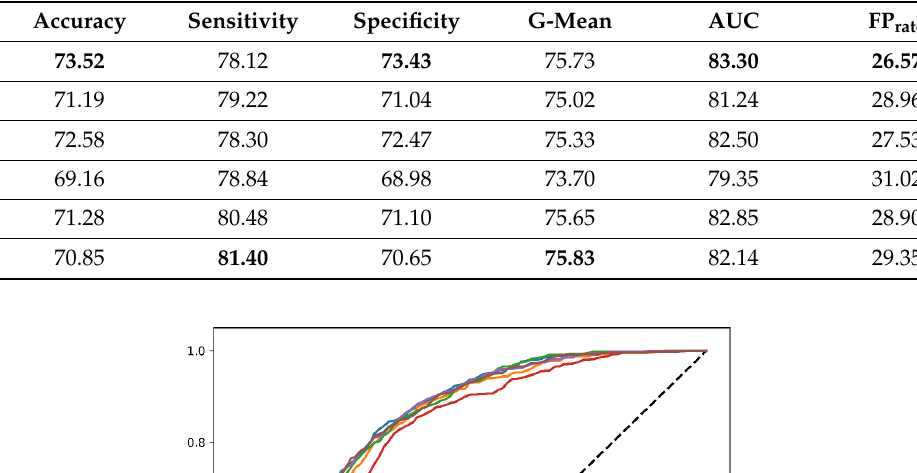
Table 3. Mean results of prediction models (%).